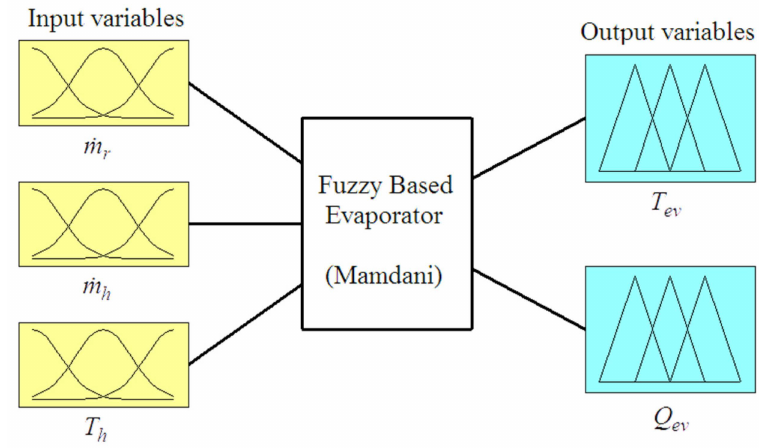
Figure 12. Three inputs and two outputs fuzzy inference system for the